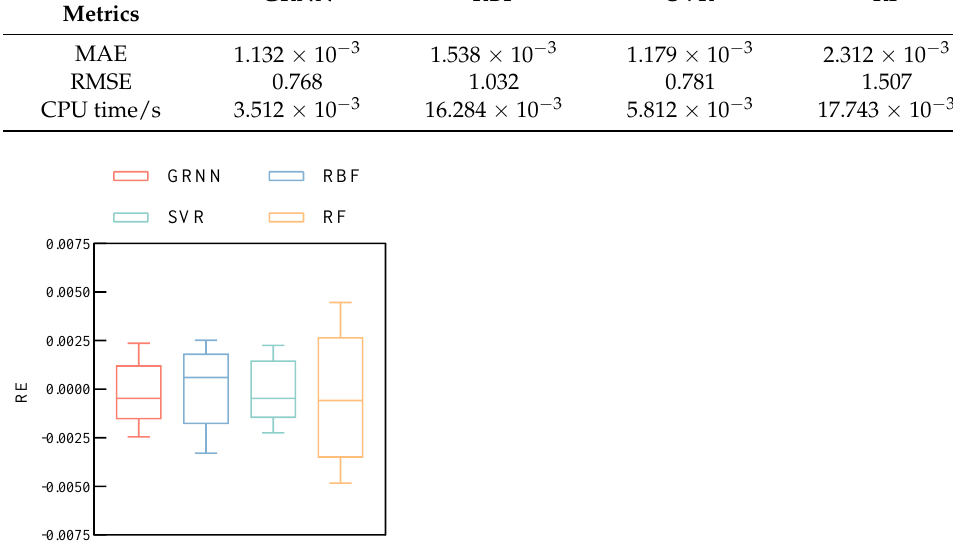
Figure 13. Box plot of verification relative error results based on different machine learning algo- rithms.